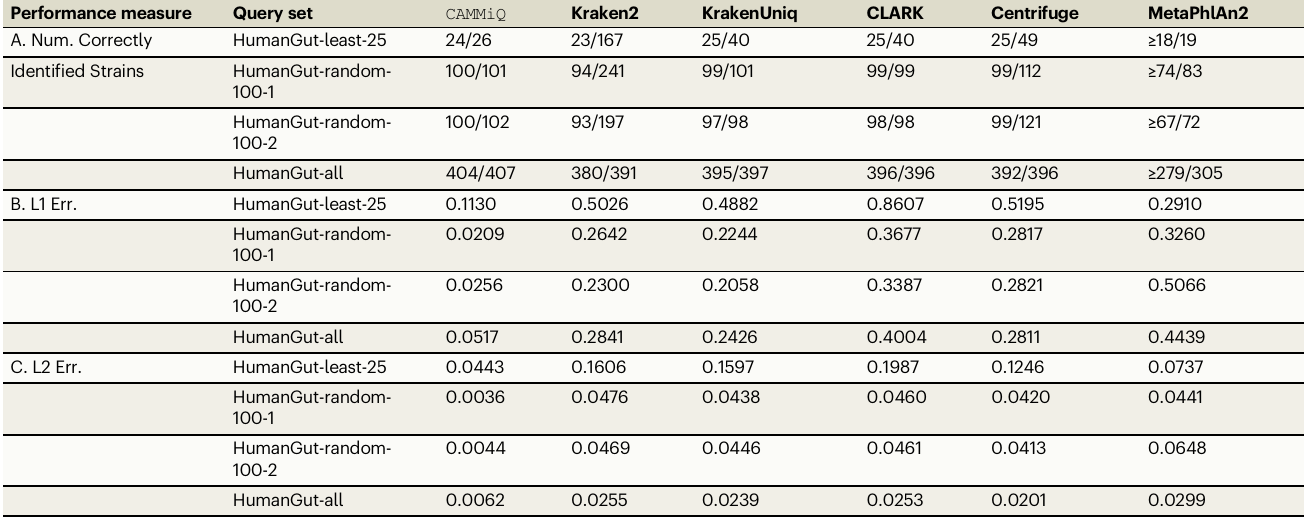
Table 5 | CAMMiQ ’ s strain level performance compared to Kraken2, KrakenUniq, CLARK, Centrifuge, and MetaPhlAn2, on the four strain-level